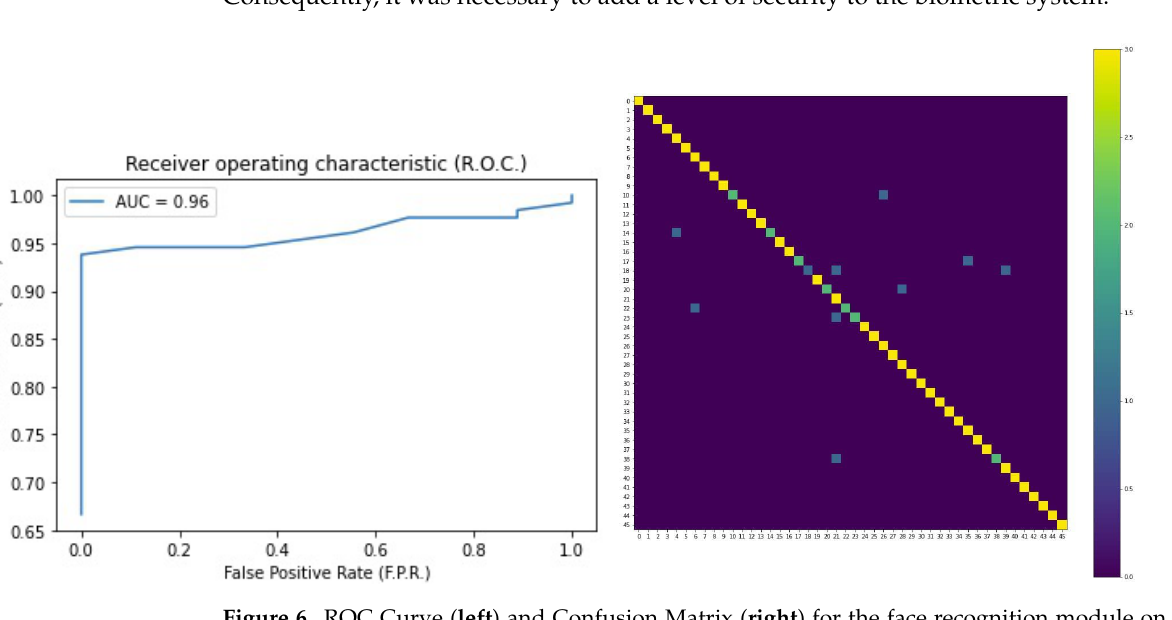
Figure 6. ROC Curve ( left ) and Confusion Matrix ( right ) for the face recognition module on the M2FRED dataset. Table 2. The deep fake videos have two components: the Source video, which represents the identity of the subject’s face applied to another video, and the Destination , which is the video on which the fake face is